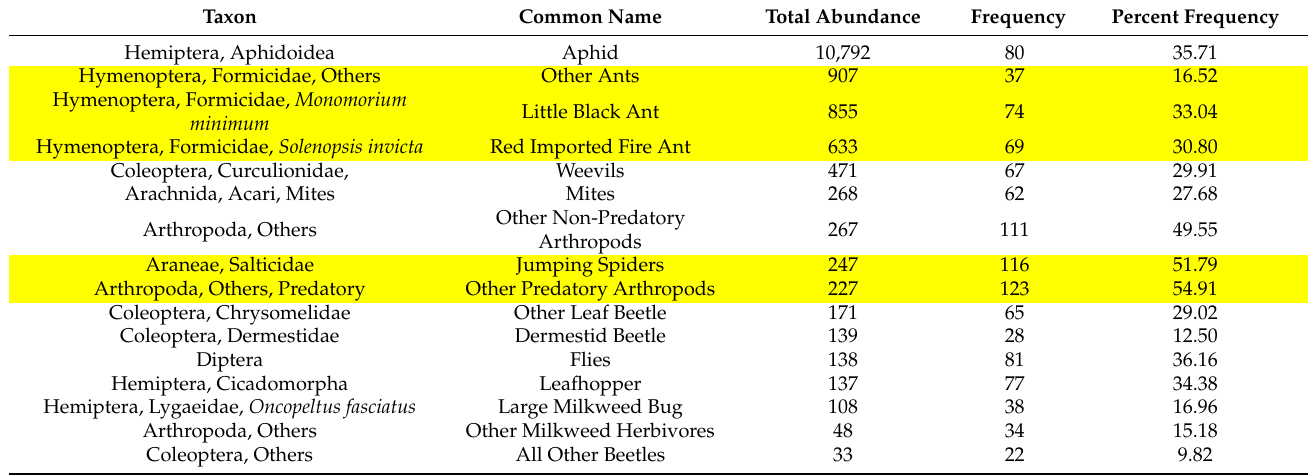
Table 1. Arthropod taxa associated with 224 eggs used for logistic regression analysis of monarch egg survivorship. Arthropod groups highlighted in yellow are predatory taxa. Percent frequency refers to the percent of monarch eggs or larvae that each taxon was associated with.